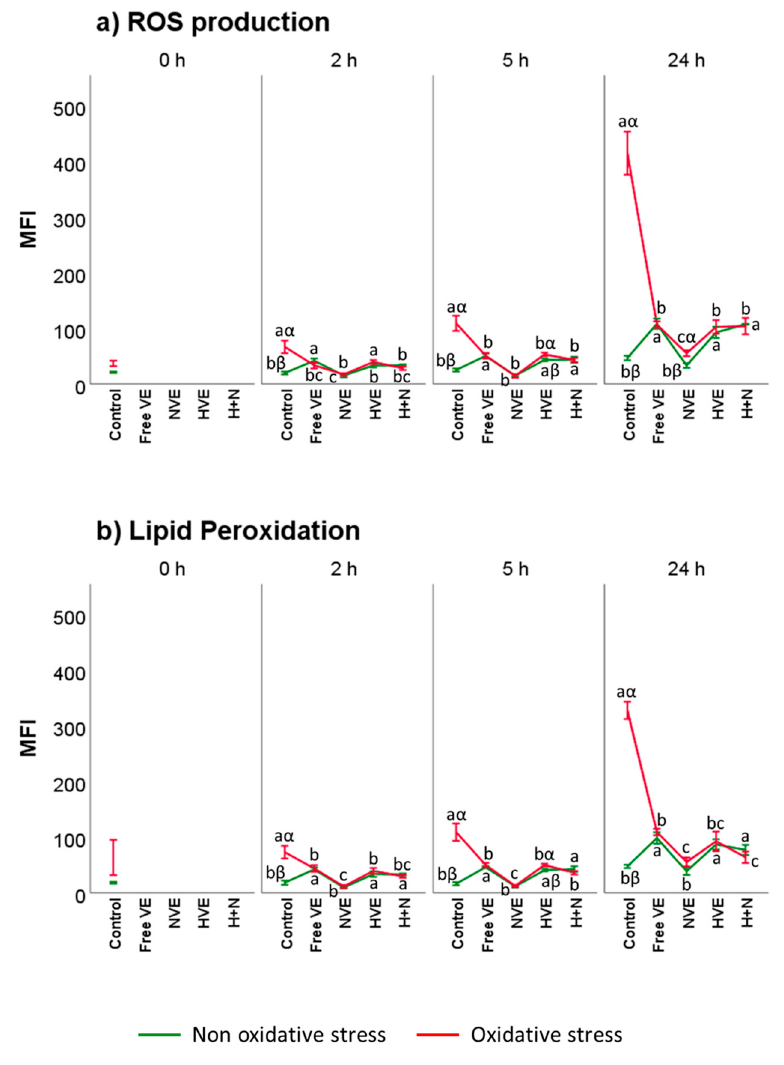
Figure 9. Vitamin E formulation effects on ROS production ( a ) and lipid peroxidation ( b ). The results show MFI (mean fluorescence intensity). Plots represent the triple interaction of different vitamin E treatments × oxidative treatment × incubation time for the flow cytometry analysis of reactive oxygen species (median fluorescence of H2DCFDA in PI − sperm) and lipid peroxidation (median green fluorescence of BODIPY C11). The various lowercase Latin letters ( p < 0.05) indicate significant differences between vitamin E treatments, while the different Greek letters ( p < 0.05) compare each treatment at the same time with a different oxidative stress status.